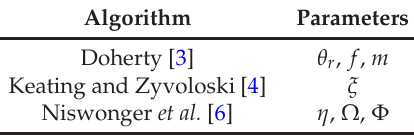
Table 1. Parameters to be assigned by the user for the algorithms with which YAGMod is compared.